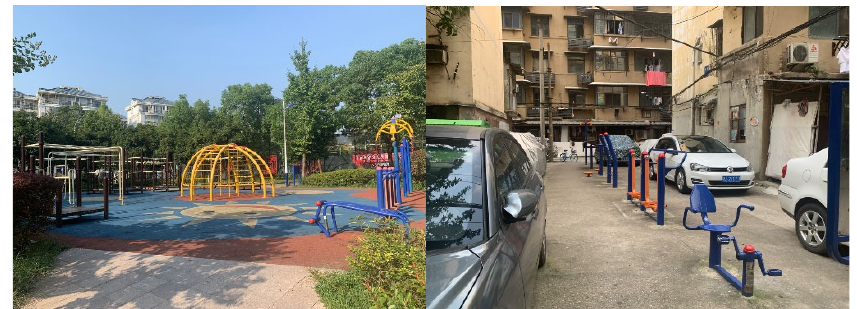
Figure 7. The fitness area in a commodity-housing neighbourhood ( left ) and a danwei neighbourhood ( right ).